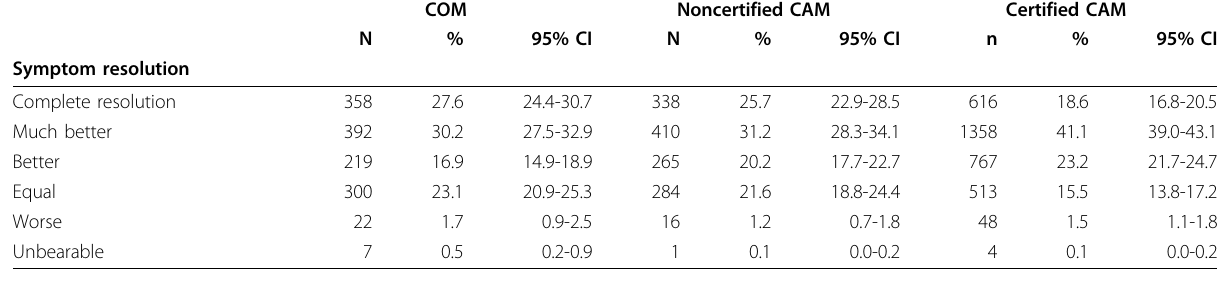
Table 4 Patient outcomes (symptom resolution, fulfilment of expectations, treatment satisfaction) COM Noncertified